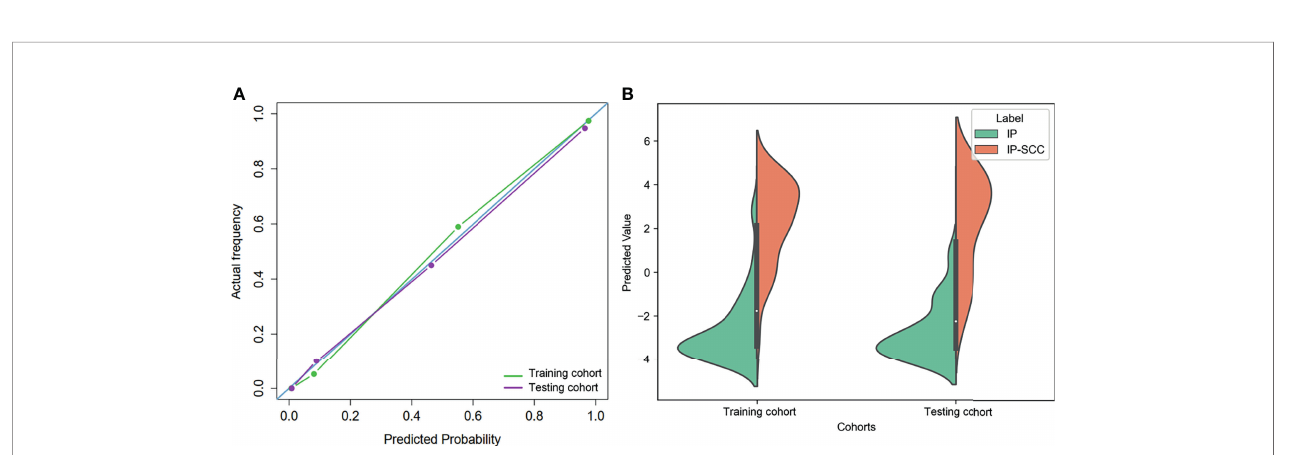
FIGURE 3 | (A) The calibration curves of the combined model in training and testing cohorts. (B) Distribution of the combined model predicted values in training and testing